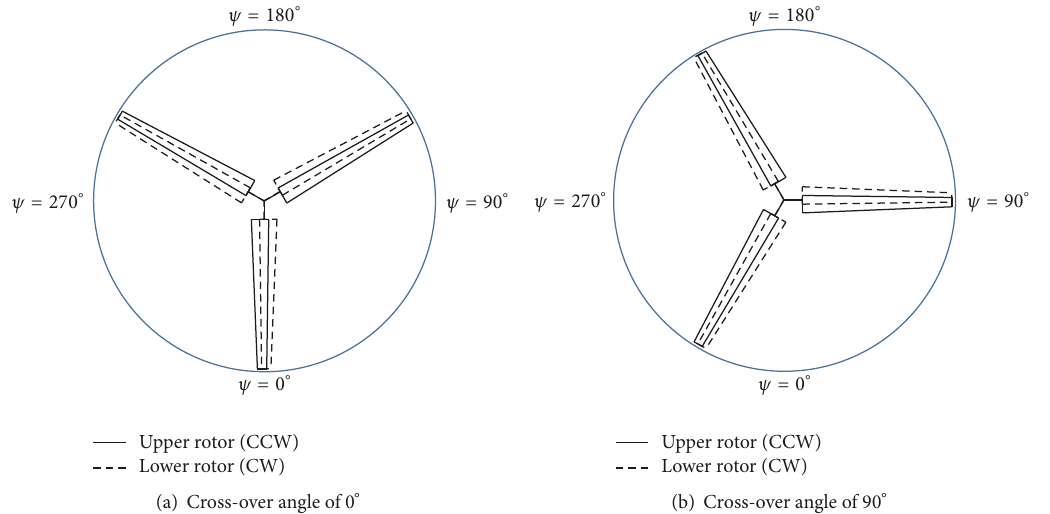
Figure 3: Definition of cross-over angle of coaxial rotor (azimuth angle is based on the rotor rotating counter-clockwise